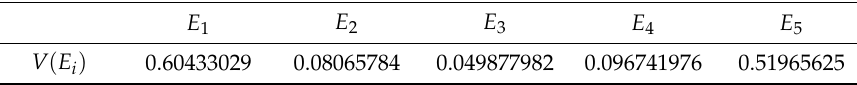
Table 9. The final score values of